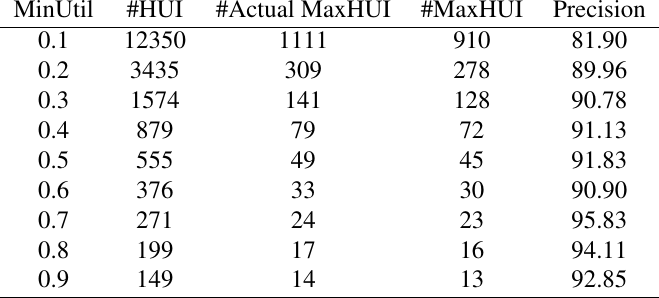
Table 5. Quality of